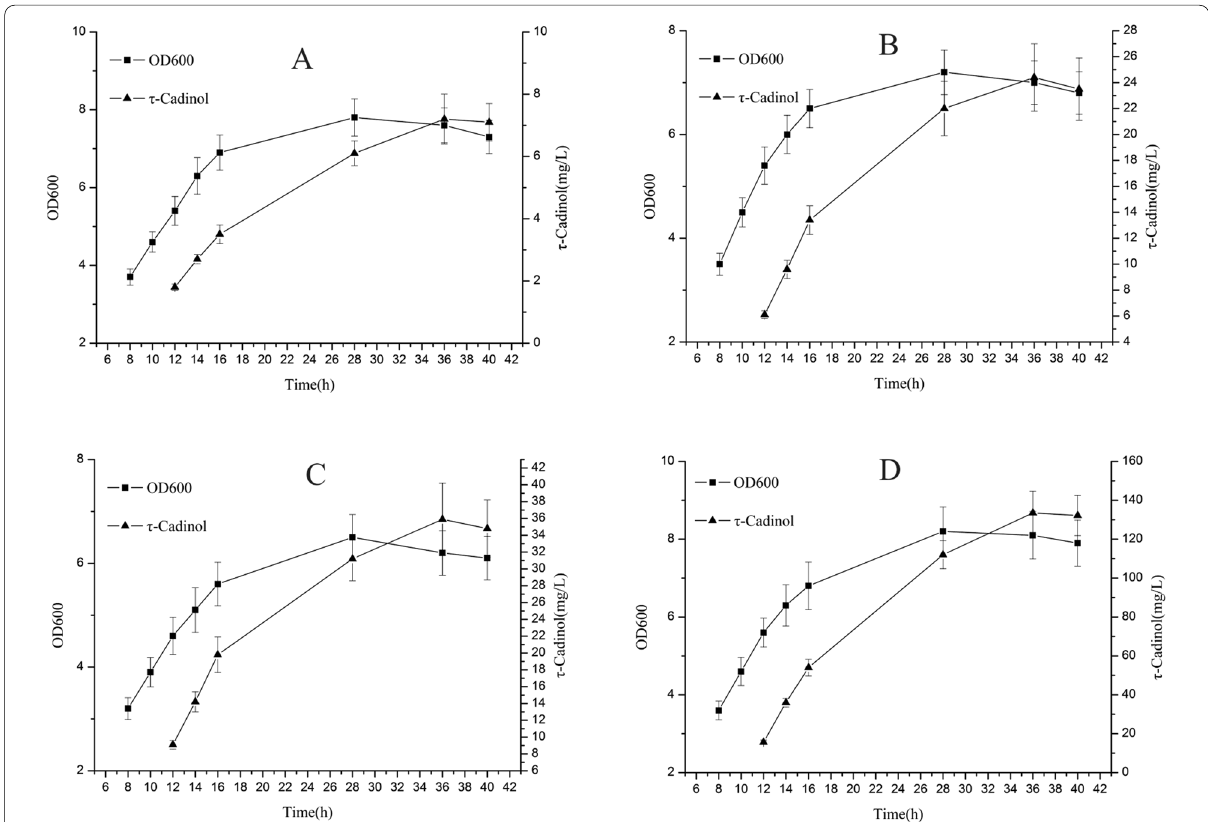
Fig. 2 The time course of cell OD600 and τ-cadinol concentration of engineered E. coli strains in shake flasks. A SY01 strain; B SY02 strain; C SY03 strain; D SY03 strain with overlay-solvent